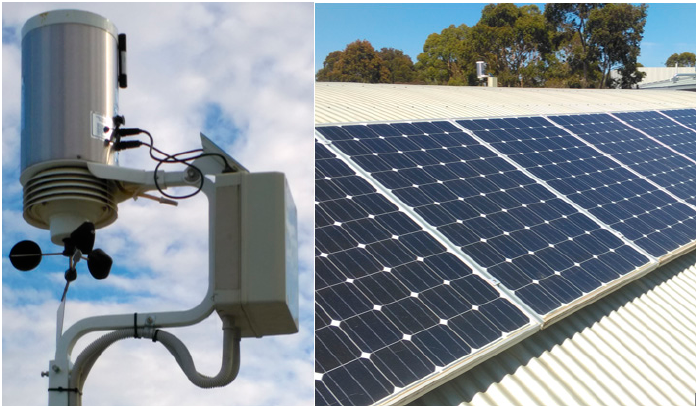
Figure 12. Weather station and PV system located at Deakin University, Australia. Table 3. PV array—Technical Specifications.